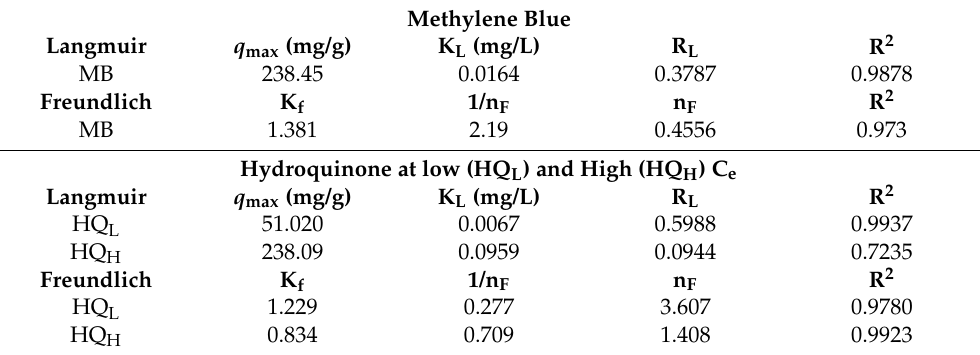
Table 3. rGO adsorption parameters for MB and